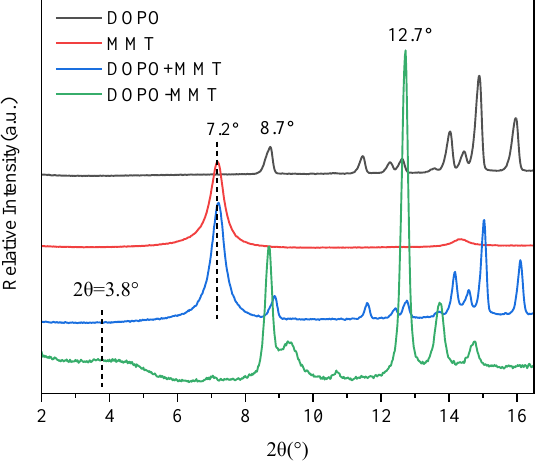
Figure 1. XRD patterns of four flame retardants.